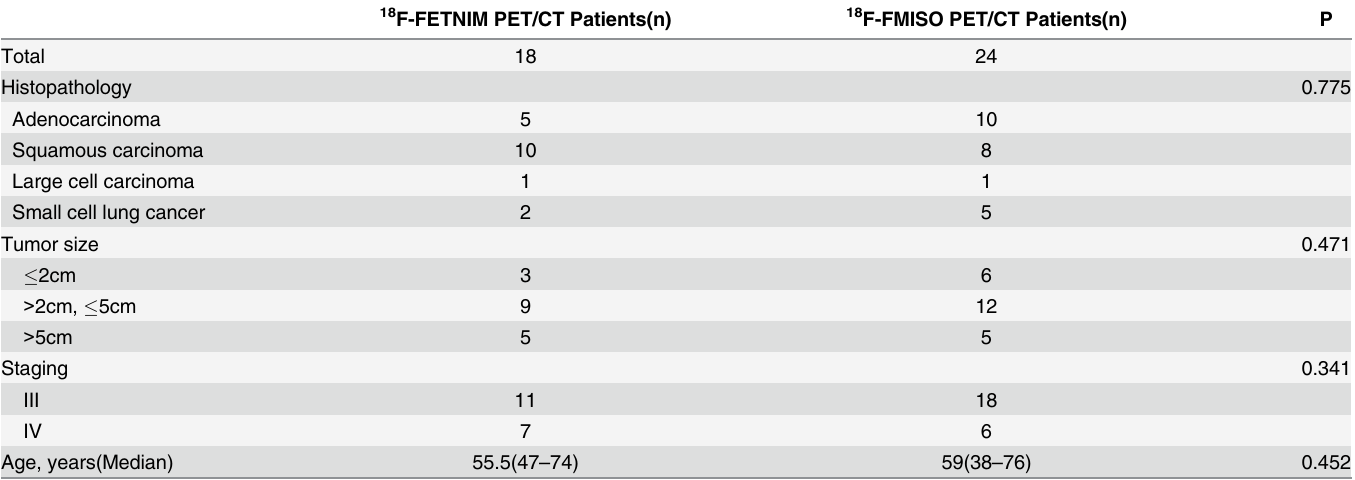
Table 1. Demographic profile and histological diagnosis in 42 patients with lung